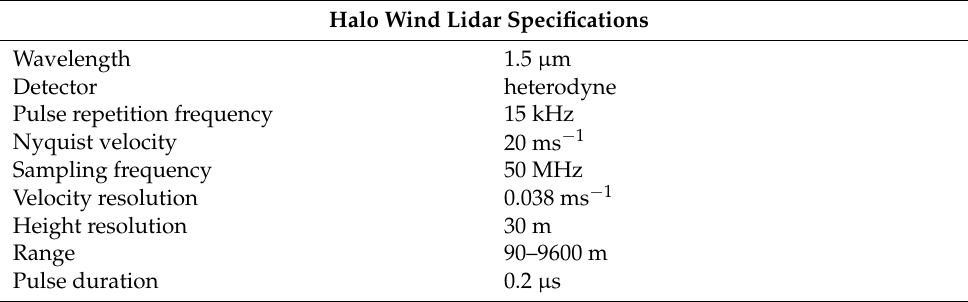
Table 2. Specifications of Halo Wind Lidar, more information at